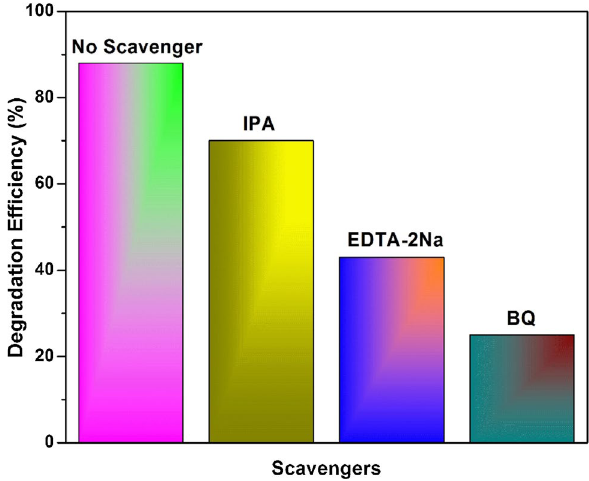
Fig. 11 Effect of scavengers on the MB dye photodegradation